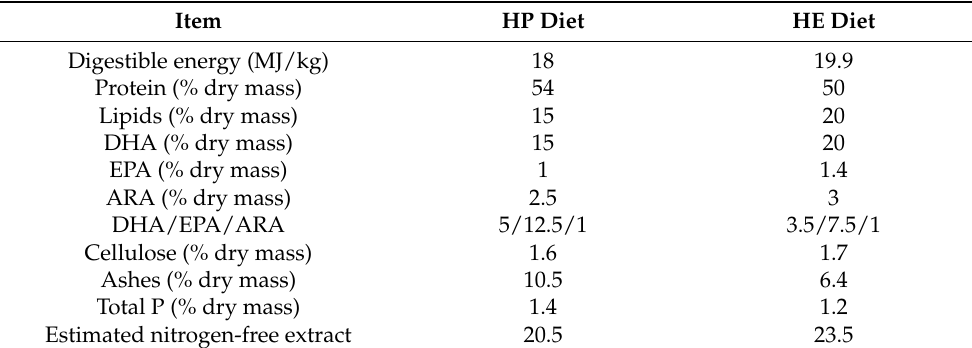
Table 1. Composition of diets used in experimental